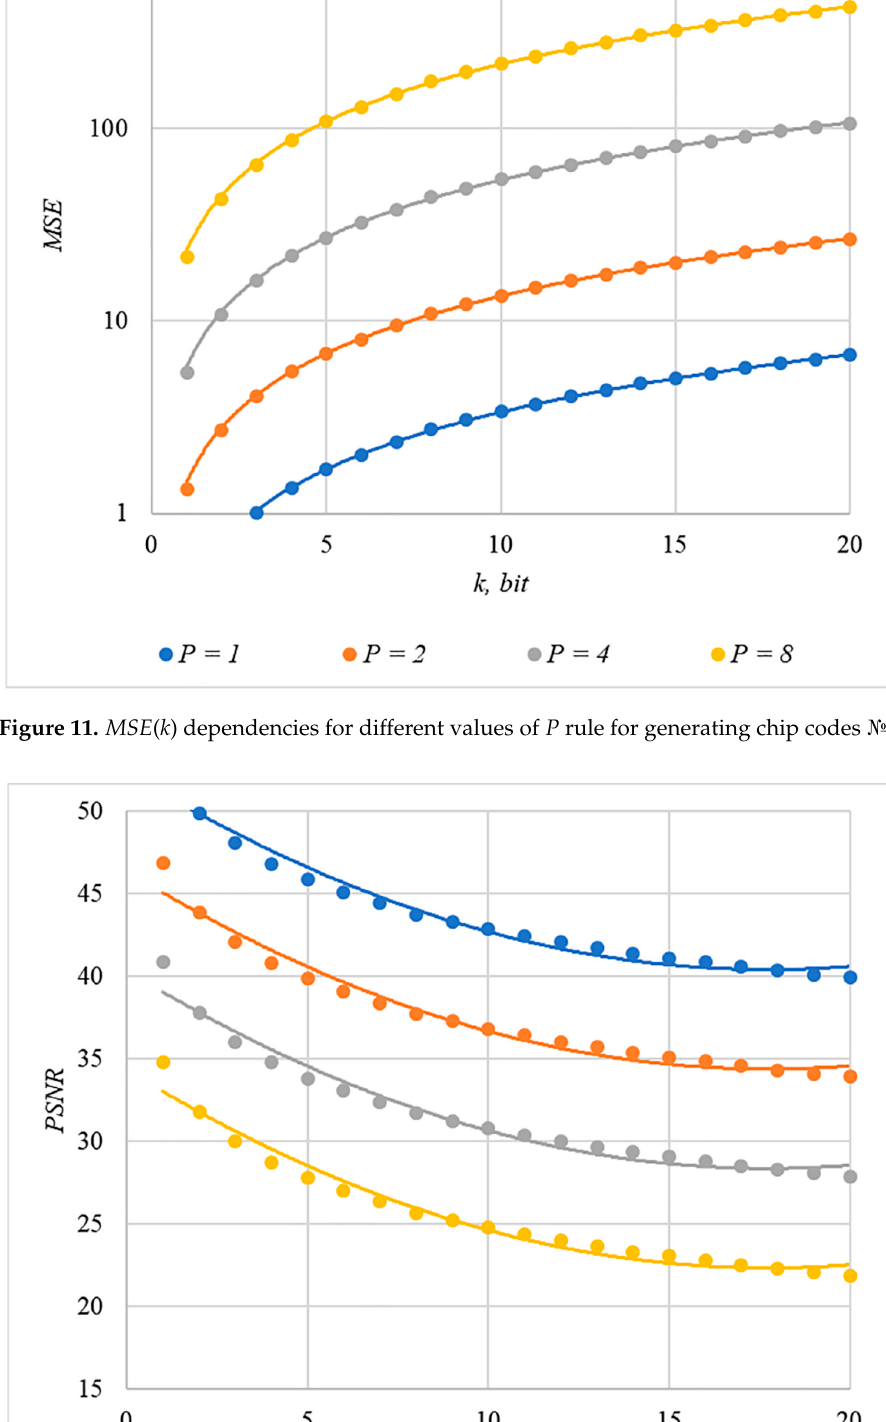
Figure 10. PSNR ( k ) dependencies for different values of 3, 4, and 5.